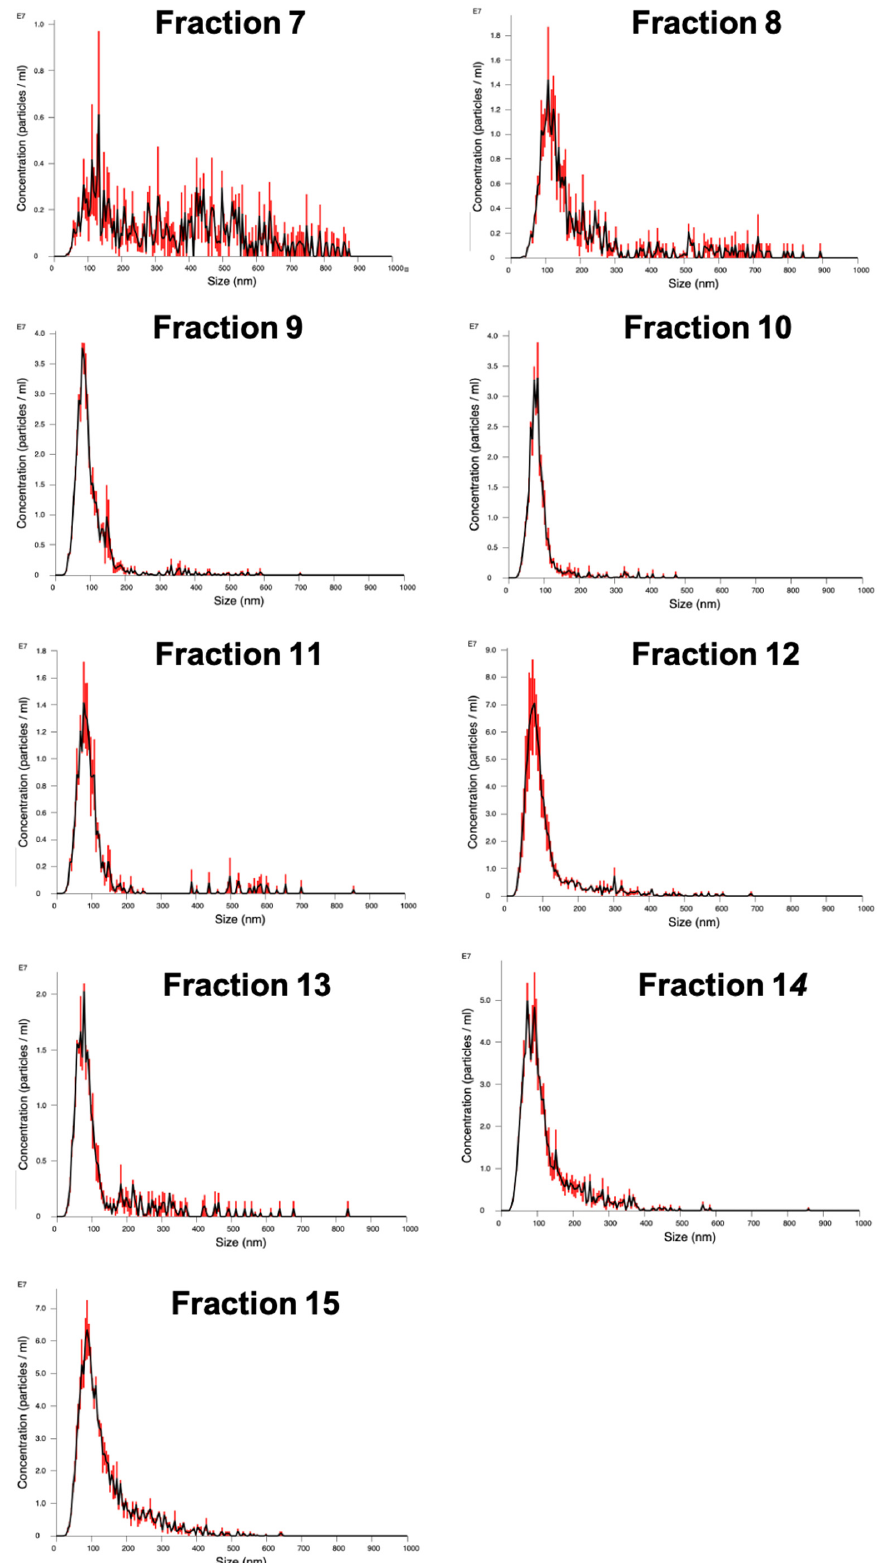
Figure A2. Nanoparticle Tracking Analysis (NTA) of fibroblast-conditioned media following size exclusion chromatography. (See Figure A1B). Fractions 7–15 of the size exclusion chromatography eluted media were analysed using NTA. Three captures were made for each fraction. Error bar indicates +/ − 1